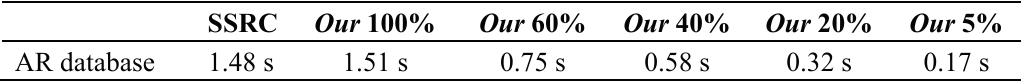
Figure 4. The relationship between the compressive sampling ratio and recognition rate of our method and SSRC for the AR Face Dataset. Table 1. The running speed for average facial images of SRC and our method on the Matlab